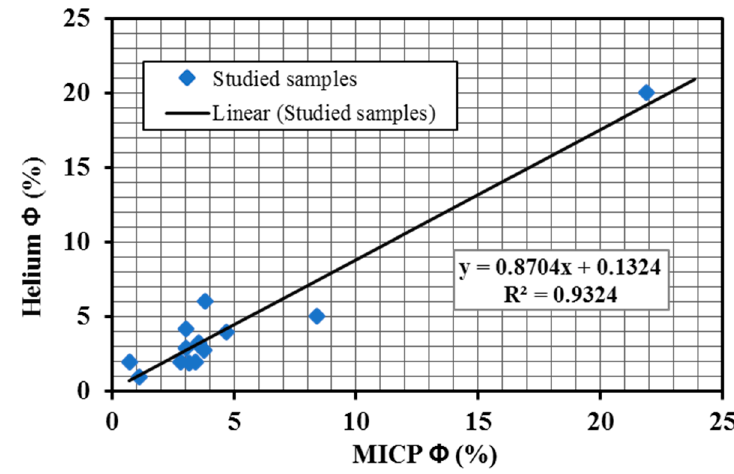
Figure 2. The cross-plot of Helium porosity (%) versus MICP porosity (%) for the studied samples.